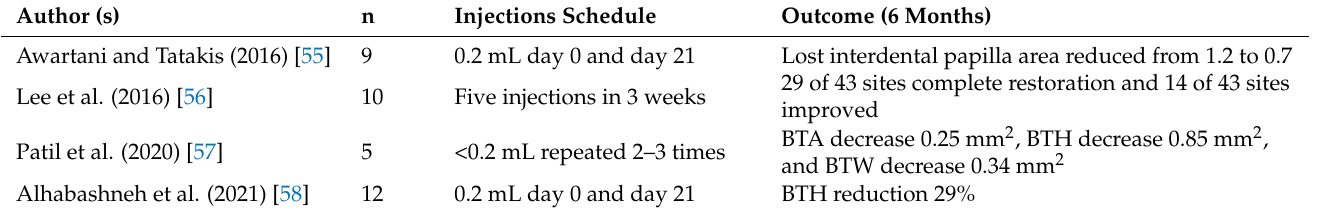
Table 4. Use of HAF to restore interdental papilla (BTA, black triangle area; BTH, black triangle height; BTW, black triangle